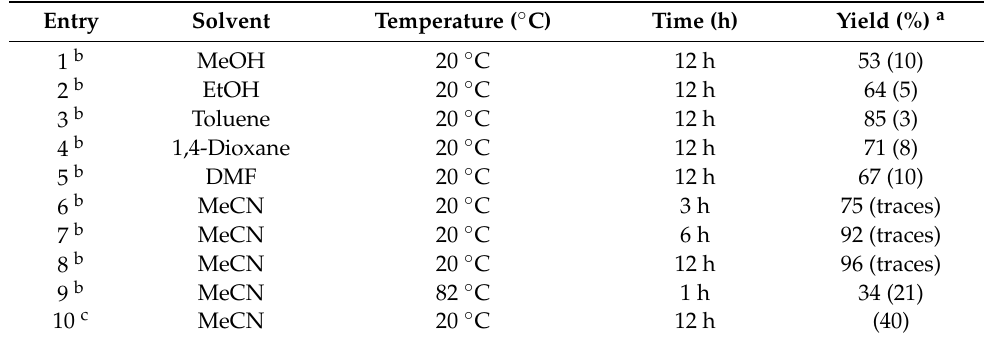
Scheme 3. Reaction of salt 1a with isonitrile 7a and amine 8a . Table 1. Reaction optimization for imidamide 2a Table 1. Reaction optimization for imidamide 2a synthesis.